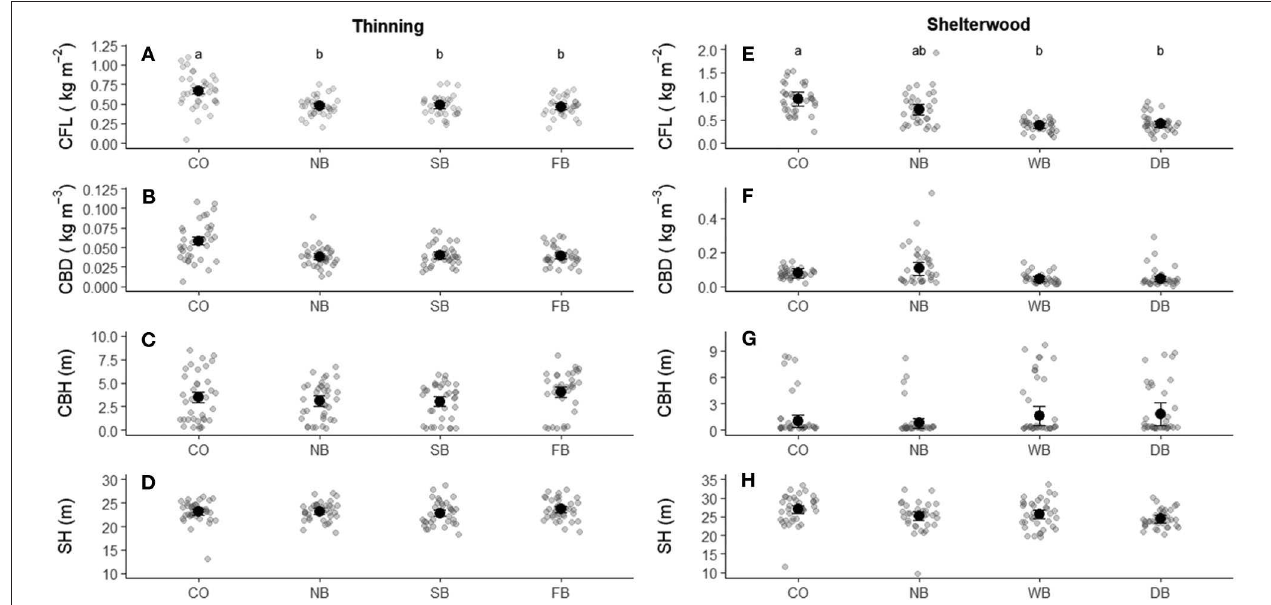
FIGURE 6 | Canopy fuel variables by treatment in 2015 (22 years post-treatment) for (A–D) Thinning and (E–H) Retention Shelterwood. Treatment means and standard error in black; individual plots in gray. Treatments: CO = Control, NB = Cut, No Burn, SB = Cut + Spring Burn, FB = Cut + Fall Burn, WB = Cut + Wet Burn, and DB = Cut + Dry Burn. CFL = canopy fuel load, CBD = canopy bulk density, CBH = canopy base height, SH = stand height. Lowercase letters denote statistical differences between treatments within a sampling period at α =